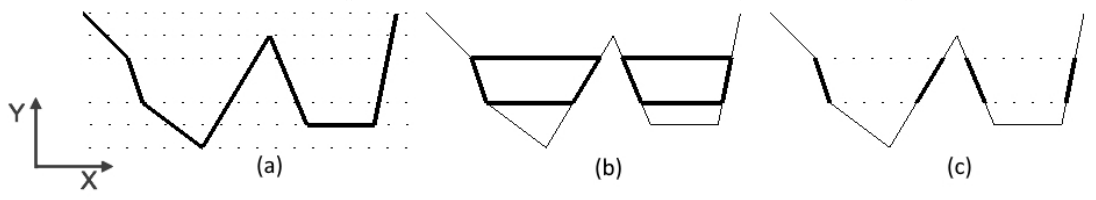
Figure 4. ( a ) Successive elevations of a natural section; ( b ) The trapezoidal subsections between two successive elevations; ( c ) The wetted perimeters of the subsections.